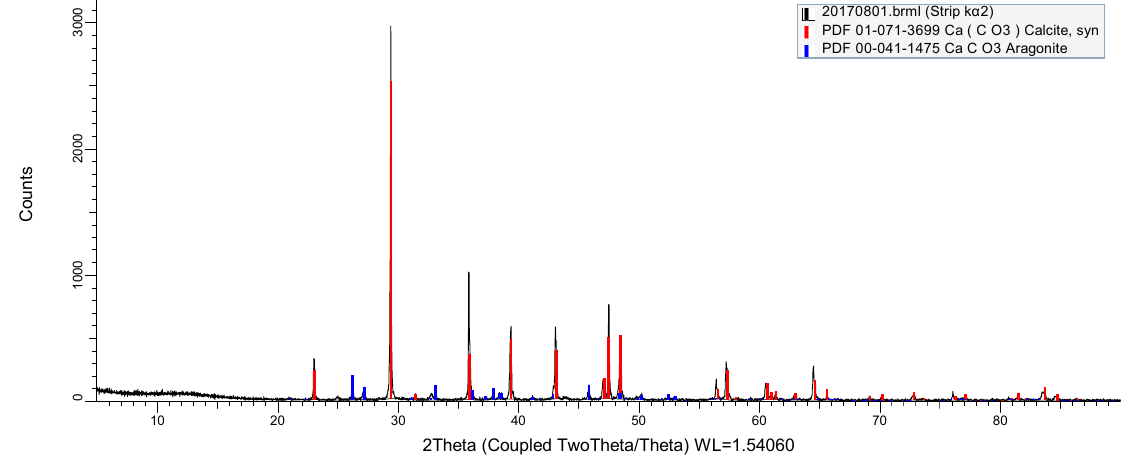
Figure A4. XRD peak patterns of the precipitate from the KSTM-SW leachate from the lightweight aggregate.